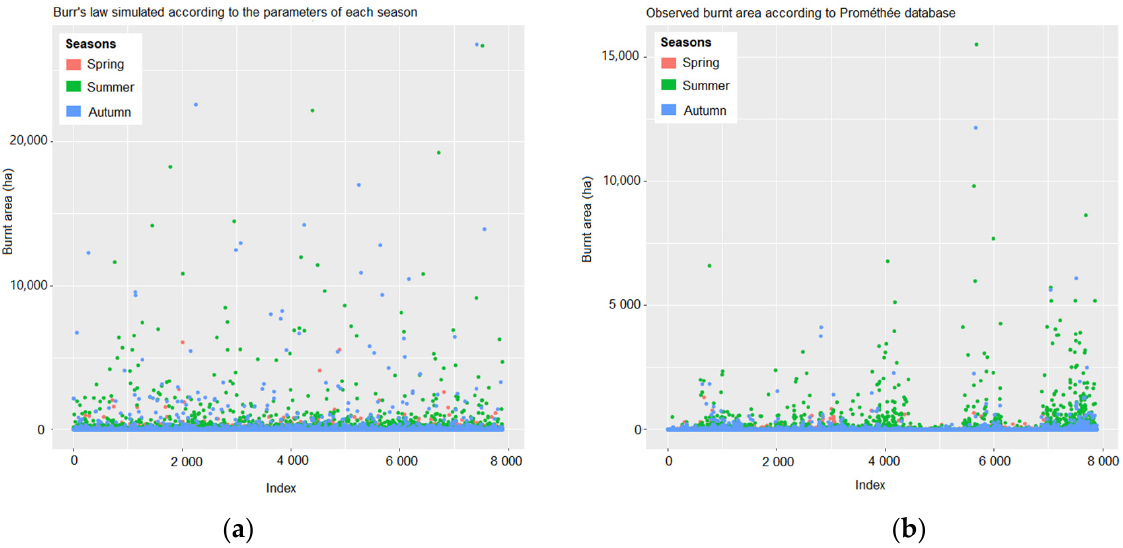
Figure 7. Burnt surface simulated with Burr’s law ( a ), and compared to the observed data from the Prométhée database ( b ).